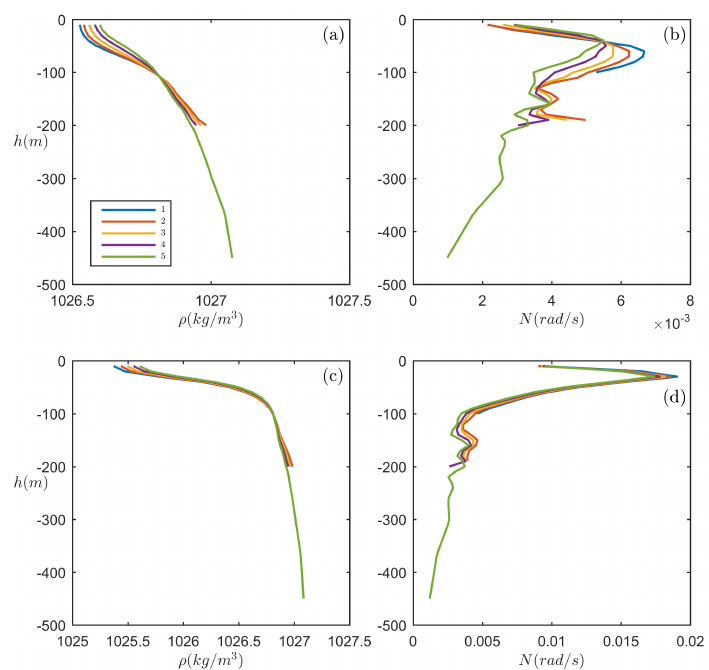
Figure 11. Background density and buoyancy frequency distribution along the transect of the Malvinas Current case. ( a , b ) are situations in summer, while ( c , d ) are in winter. Five different lines in each panel represent situations on the chosen five points along the wave propagation transect.